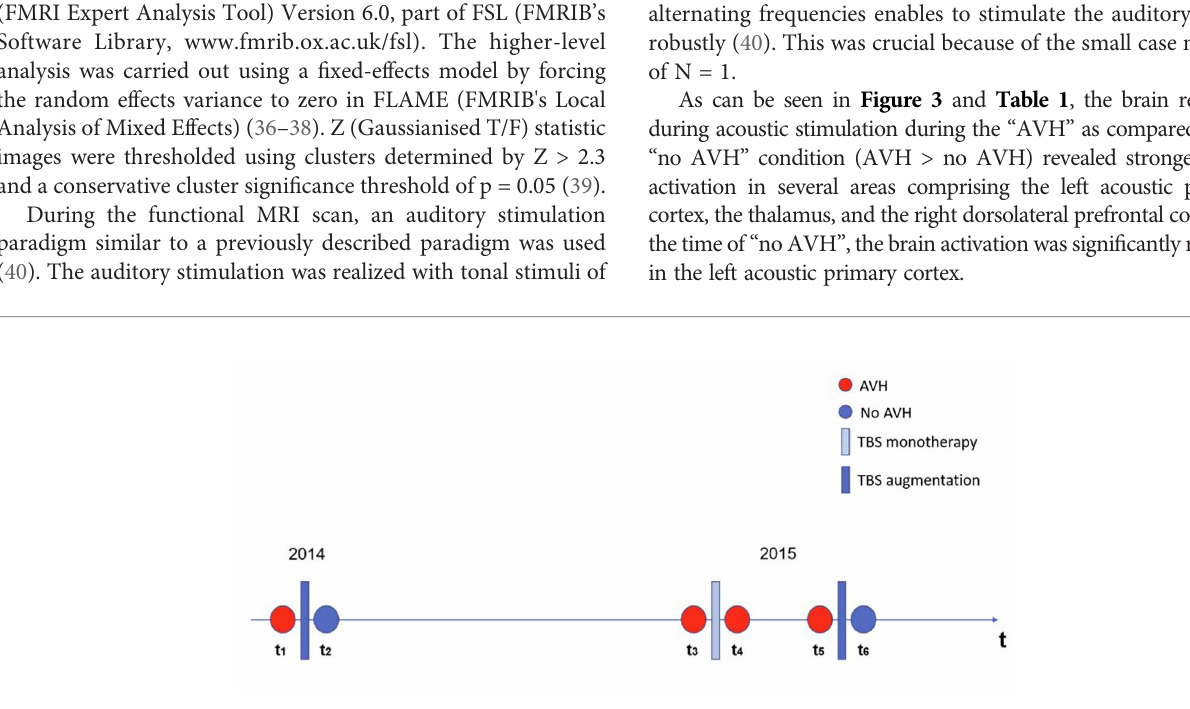
FIGURE 2 | Schematic depiction of the functional magnetic resonance imaging (fMRI) data analysis design. The timeline (t) represents all MRI measurement times (t1 – t6). TBS monotherapy is represented by a light blue bar, and TBS augmentation is represented by a dark blue bar. At t1, t3, t4, and t5 the patient experienced auditory-verbal hallucination (de fi ned as “ AVH ” ) indicated by a red colored circle. At t2, and t6, the patient experienced no symptoms of AVH (de fi ned as “ no AVH “ ) indicated by a blue colored circle.